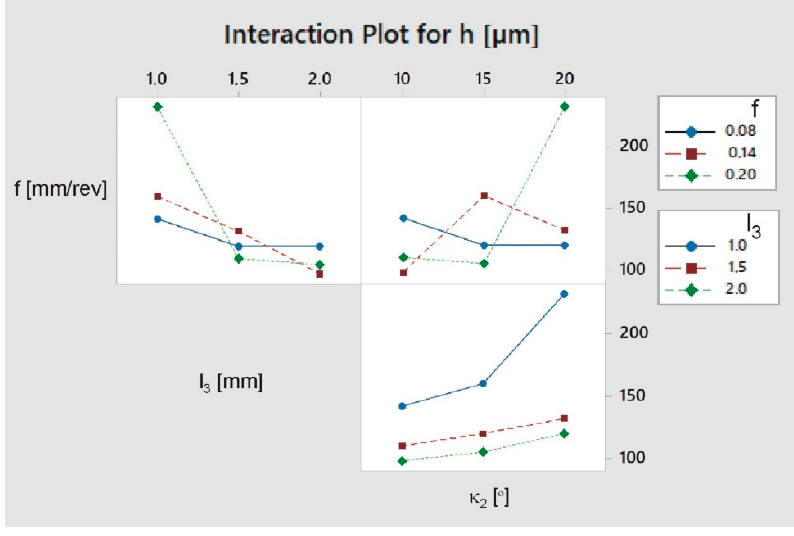
Figure 10. Interaction plot for burr height h .